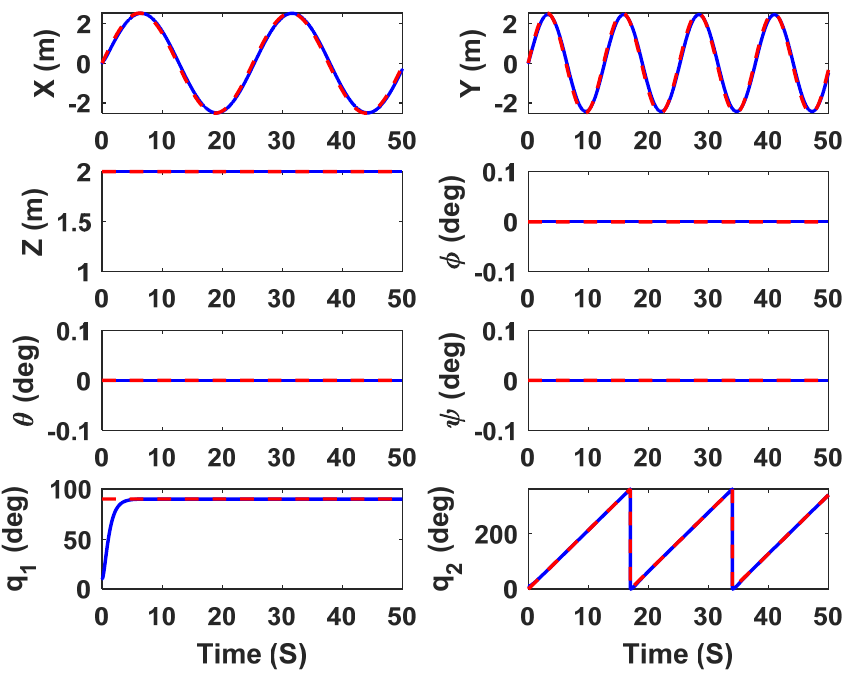
Figure 8. CR tensions in the first control case.